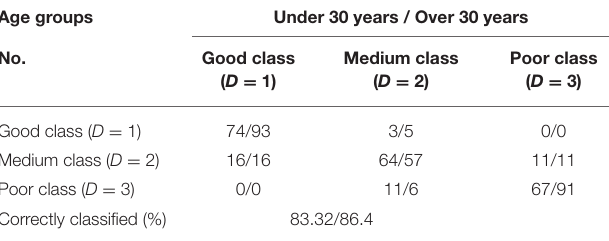
TABLE 6 | The average hit rate of 5-fold cross-validation in different age